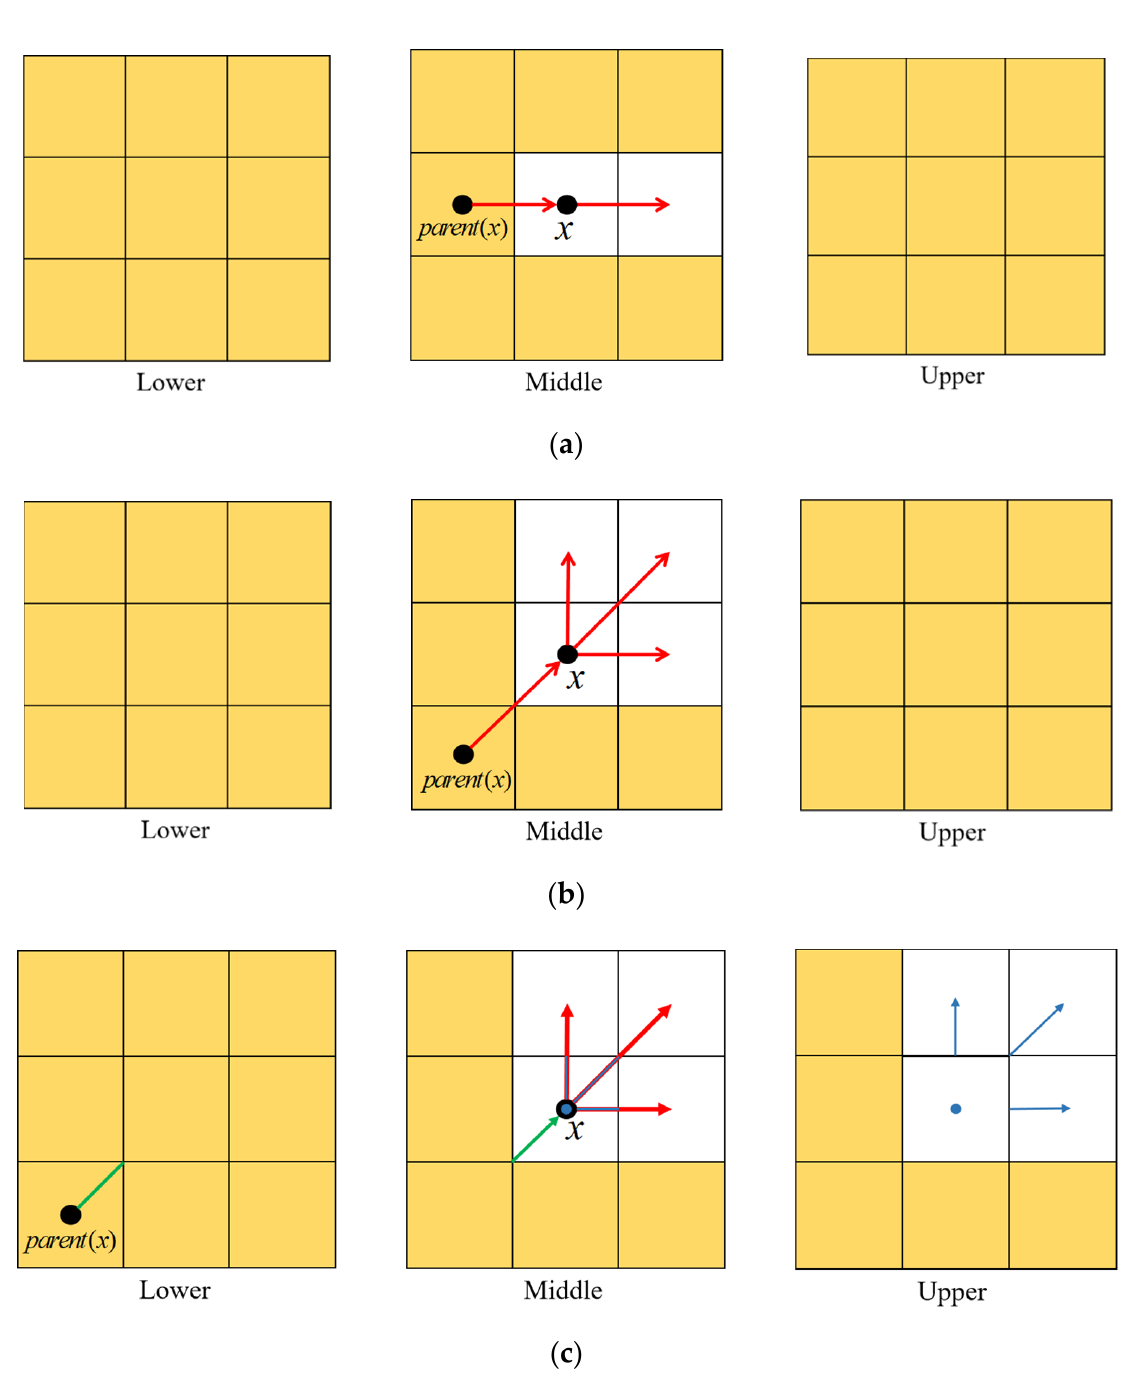
Figure 7. Three-dimensional JPS algorithm neighbor-pruning law. ( a ) Pruning rule under the linear extension direction in the same plane. The expansion direction of the 3D JPS algorithm is restricted to the original expansion direction in the unique plane. ( b ) Pruning rule under the diagonal extension direction of the same plane. The expansion direction of the 3D JPS algorithm is restricted to the original expansion direction in the unique plane as well as above and to the right of the current grid. ( c ) Pruning rules under the diagonal expansion direction of the body. The extension direction of the 3D JPS algorithm will involve two planes. Where the green arrow indicates the expansion direction of the parent node from the lower layer to the current node, the red arrow indicates the expansion direction of the middle layer, and the blue arrow indicates the expansion direction from the current node to the upper layer.